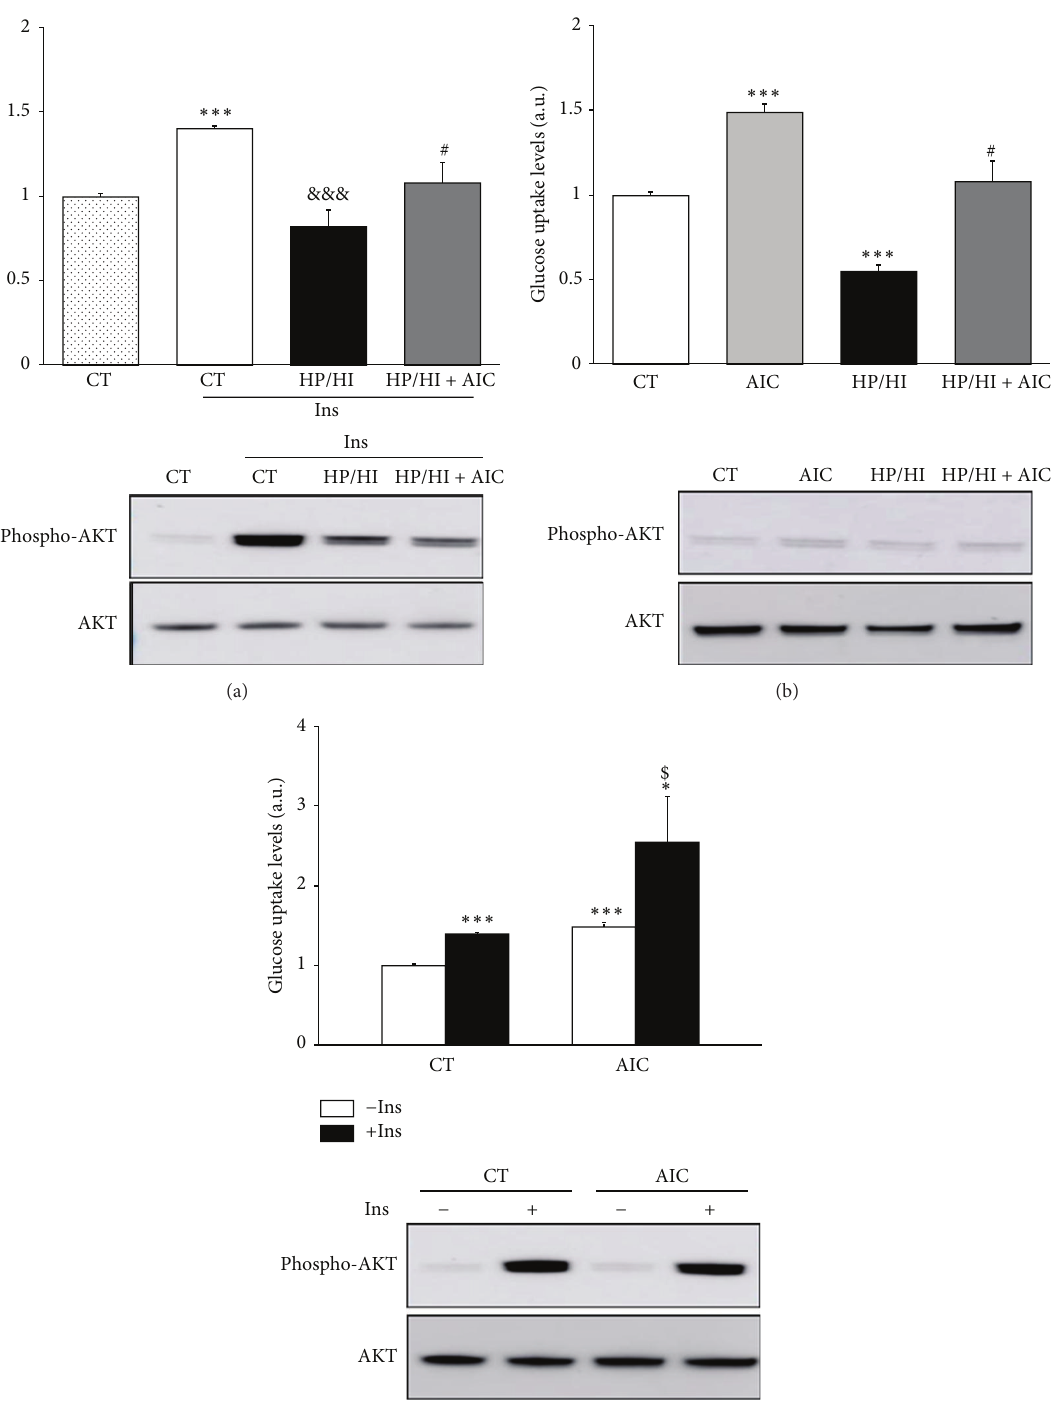
Figure 5: AICAR stimulation attenuates HP/HI-induced glucose uptake impairment in HL-1. HL-1 cells were stimulated with HP/HI for 16h in the presence or absence of AICAR (24 h), and [ 3 H]-deoxyglucose uptake (up) and AKT phosphorylation (down) were assessed in the presence (a) and absence (b) of insulin (200 nmol/L, 10min). [ 3 H]-deoxyglucose uptake (up) and AKT phosphorylation (down) determination in HL-1 cells stimulated with AICAR (24 h) in the presence and absence of insulin (200 nmol/L, 10min) (c). Data are expressed as mean ± SD of 4 different experiments performed in duplicate. ( ∗ 𝑃 < 0.05 , ∗∗∗ 𝑃 < 0.001 versus control cells without insulin stimulation; &&& 𝑃 < 0.001 versus control cells stimulated with insulin; # 𝑃 < 0.05 versus HP/HI-challenged cells stimulated with insulin (a) or without insulin (b); $ 𝑃 < 0.05 versus AICAR-treated cells stimulated with